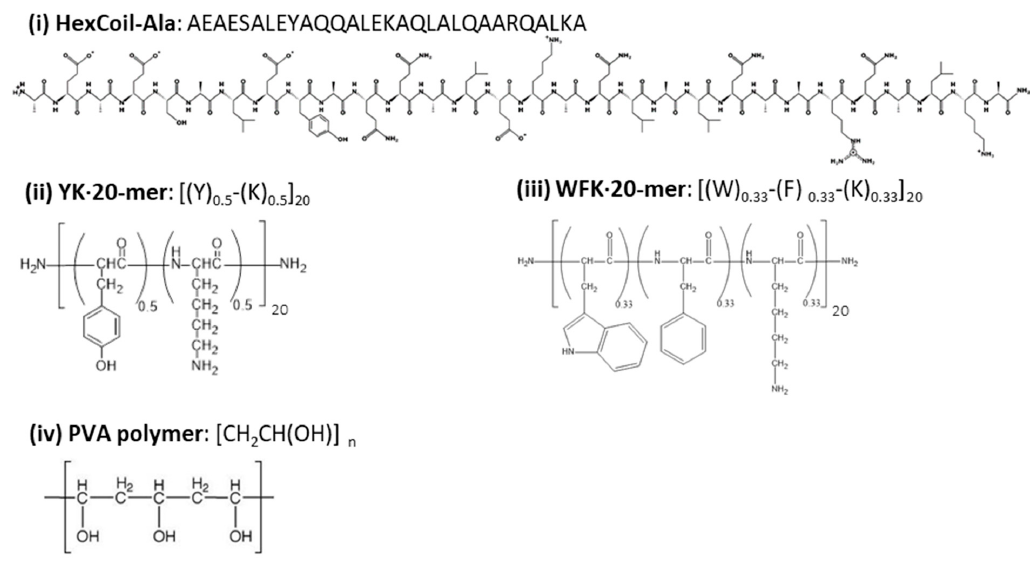
Figure 2. The structures of the three peptides and poly(vinyl alcohol) (PVA) polymer that were used for single-wall carbon nanotube (SWCNT) dispersion.